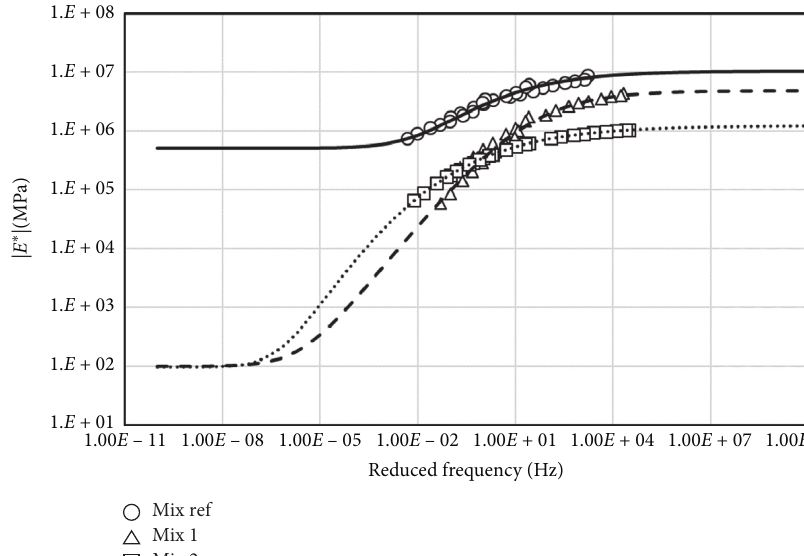
Figure 7: Dynamic modulus master curves.